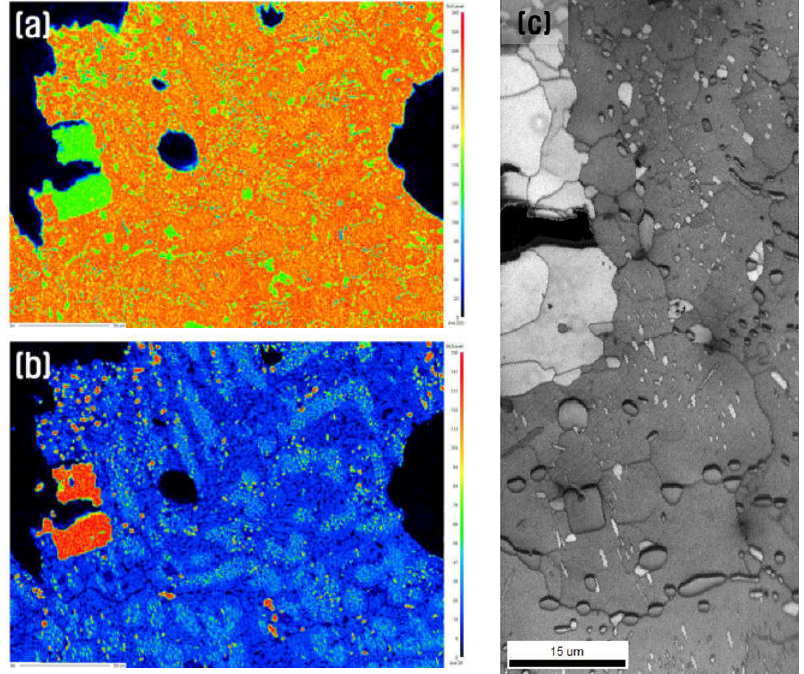
Figure 10. Microstructure of SSA8030 solders after the creep test at 175 °C: ( a , b ) Sn and Sb mapping using FE-EPMA, respectively; ( c ) IQ map of EBSD.